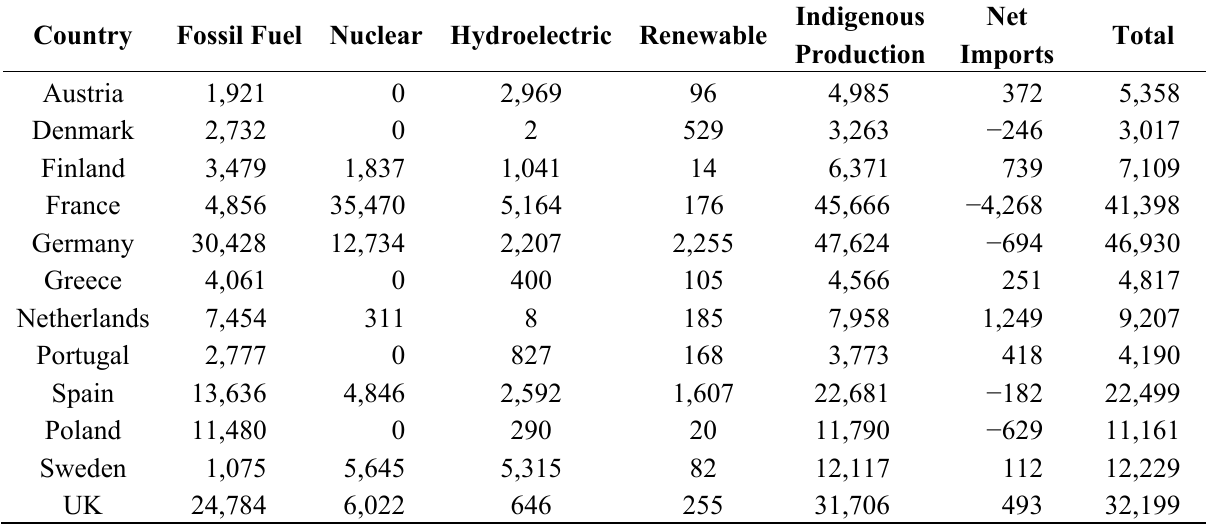
Table 1. Average annual electric power generation by type and net imports in gigawatt hours, January 2004 to March 2008.